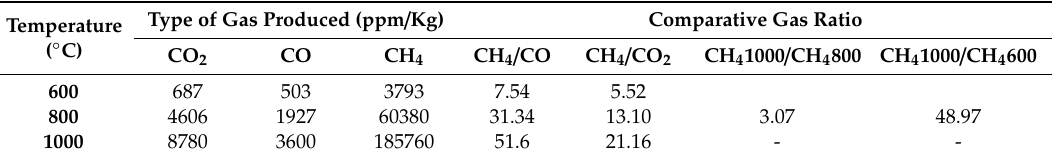
Table 1. Quantitative gas analysis during heat treatment of latex at horizontal tube furnace for 15 min at three different temperatures.